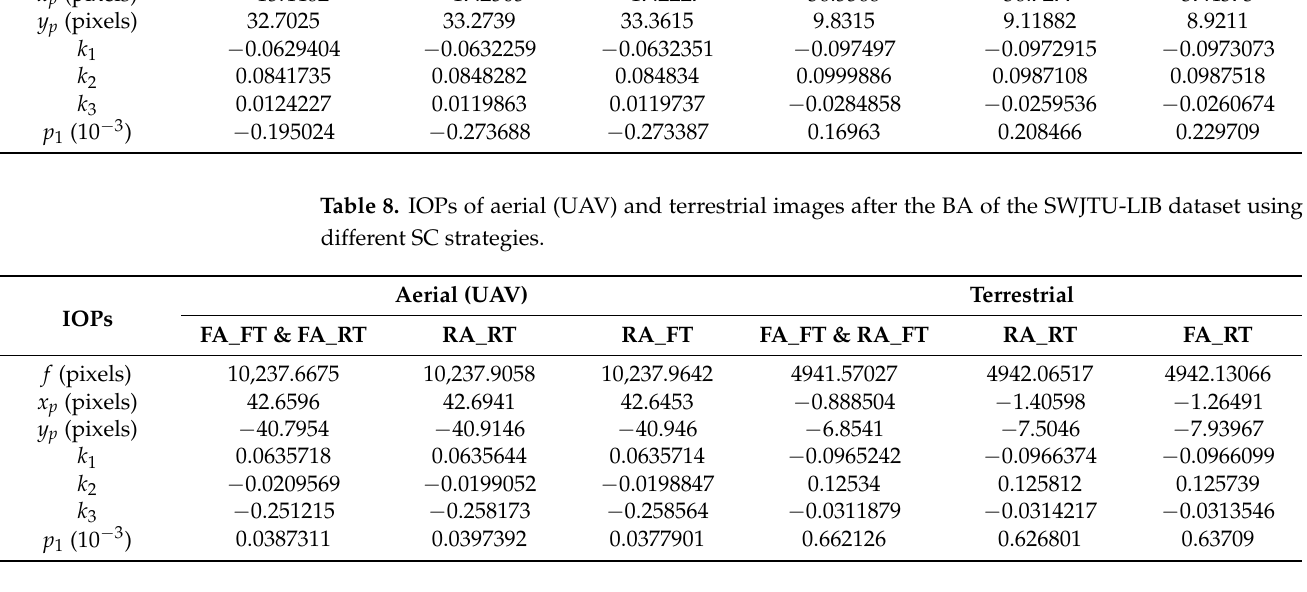
Table 9. IOPs of aerial (UAV) and terrestrial images after the BA of the SZU-YPS dataset using different SC